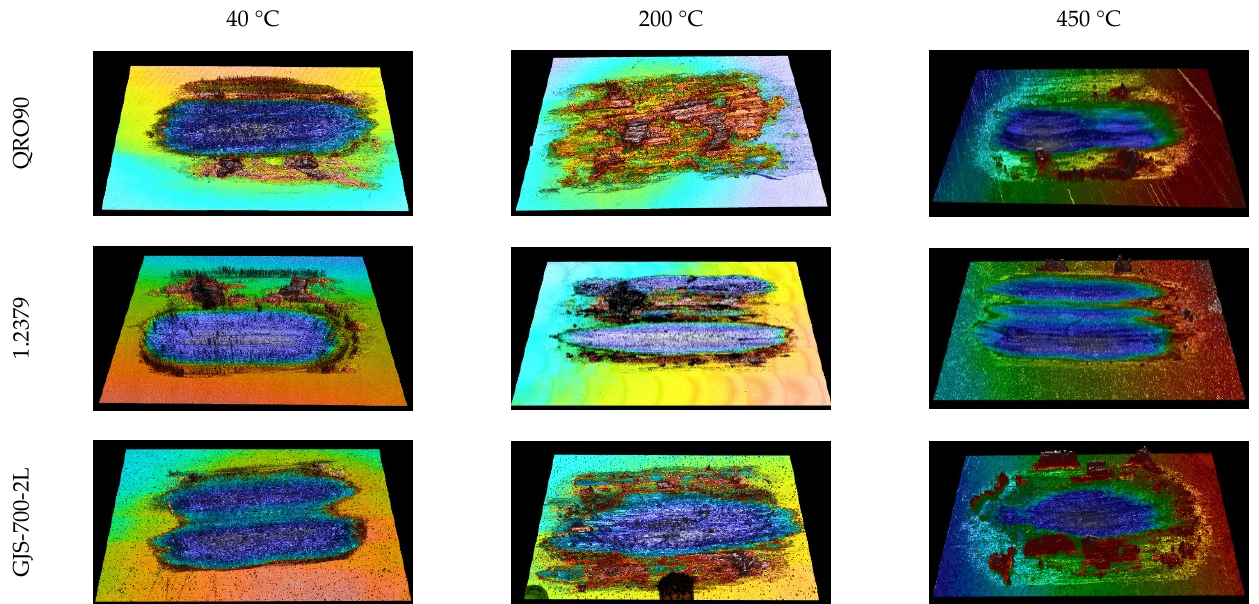
Figure 5. Wear tracks for disks tested against 2011 pins.